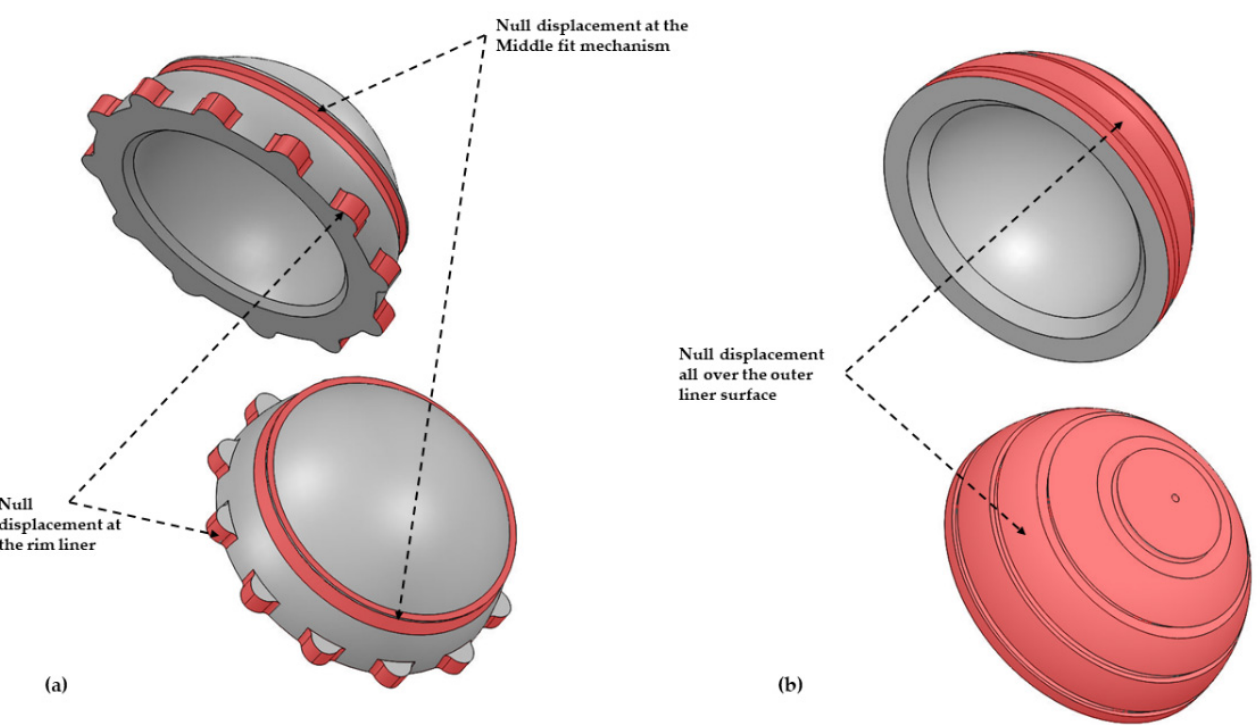
Figure 4. 3D model liner with boundary conditions. ( a ) Cementless acetabular fixation. ( b ) Cemented acetabular.